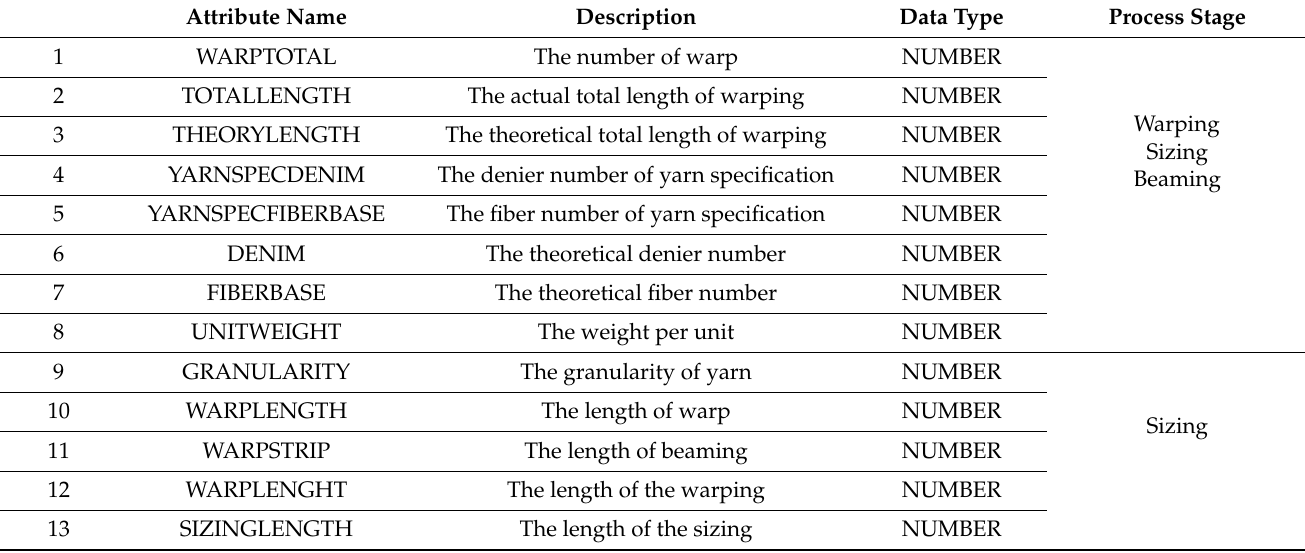
Table 6. Features of the training